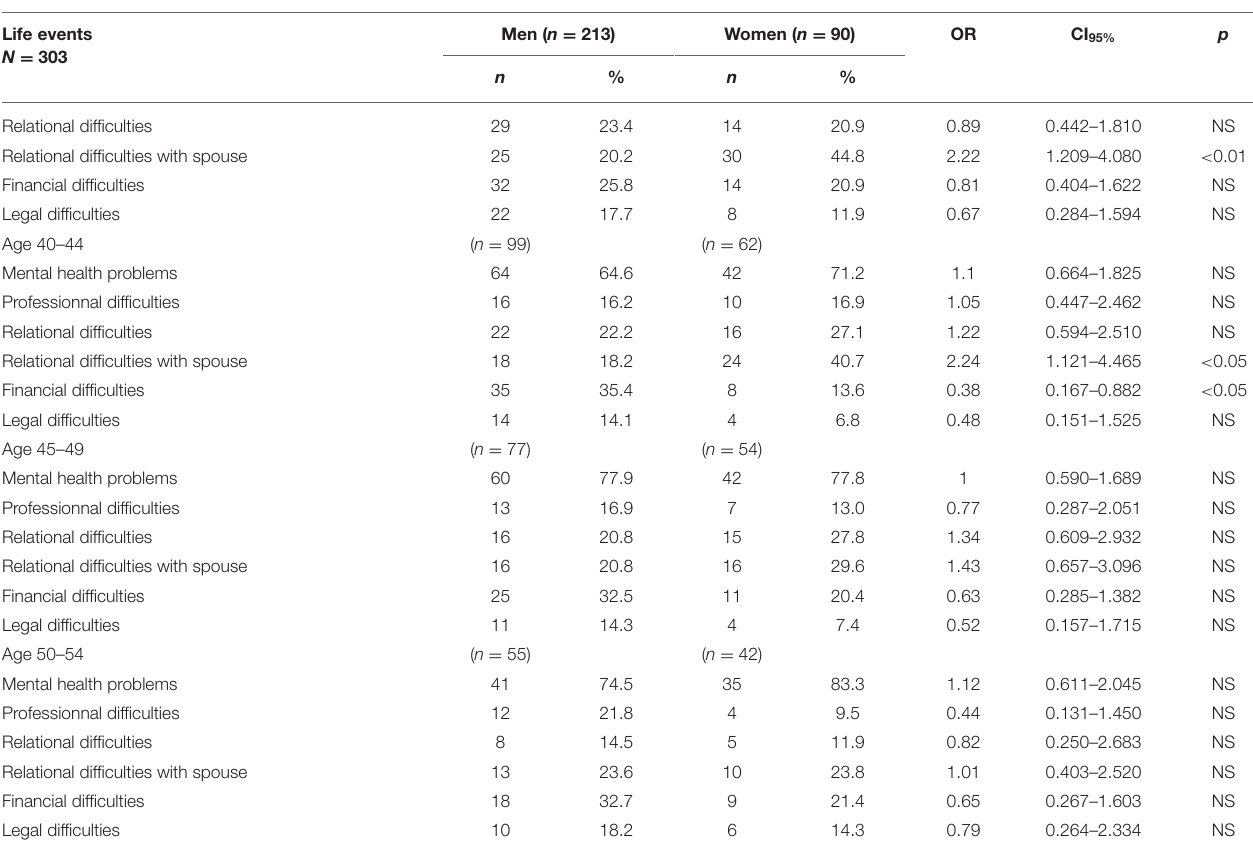
Mental health problems included variables such as Axis I diagnosis, personality disorder, alcohol and drug abuse, number of suicide attempts, other problems of mental health, and psychiatric hospitalization. Relational difficulties with spouse include psychological, physical and sexual violence, breakups, infidelity, jealousy, control over one partner, entrapment, etc. Relational difficulties included variables such as conflict with peers, social isolation, bad influence from peers, separation or loss of a friend, etc. Academic difficulties included events such as: underachievement, failure in school, behavioral problems in school, being a bully, etc. Legal problems included all types of behaviors resulting in negative events with the justice system. Financial losses included bankruptcy, financial hardships